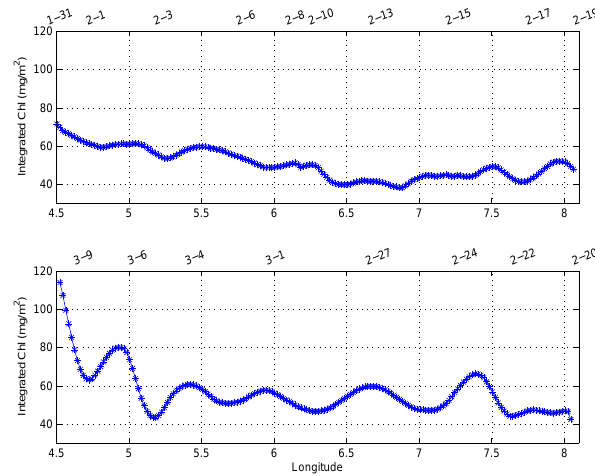
Fig. 6. Depth-integrated Chlorophyll-a ( mg/m 2 ) relating to the first 100 m of the water column. The Figure 6. Depth-integrated chlorophyll a (mgm − 2 ) of the first upper and lower panels are for the outbound and return legs of the glider mission, respectively. The 100m of the water column. The upper and lower panels are for the panels are provided with dates (MM-DD) to facilitate interpretation. outbound and return legs of the glider mission, respectively. The panels are provided with dates (MM-DD) to facilitate interpreta-